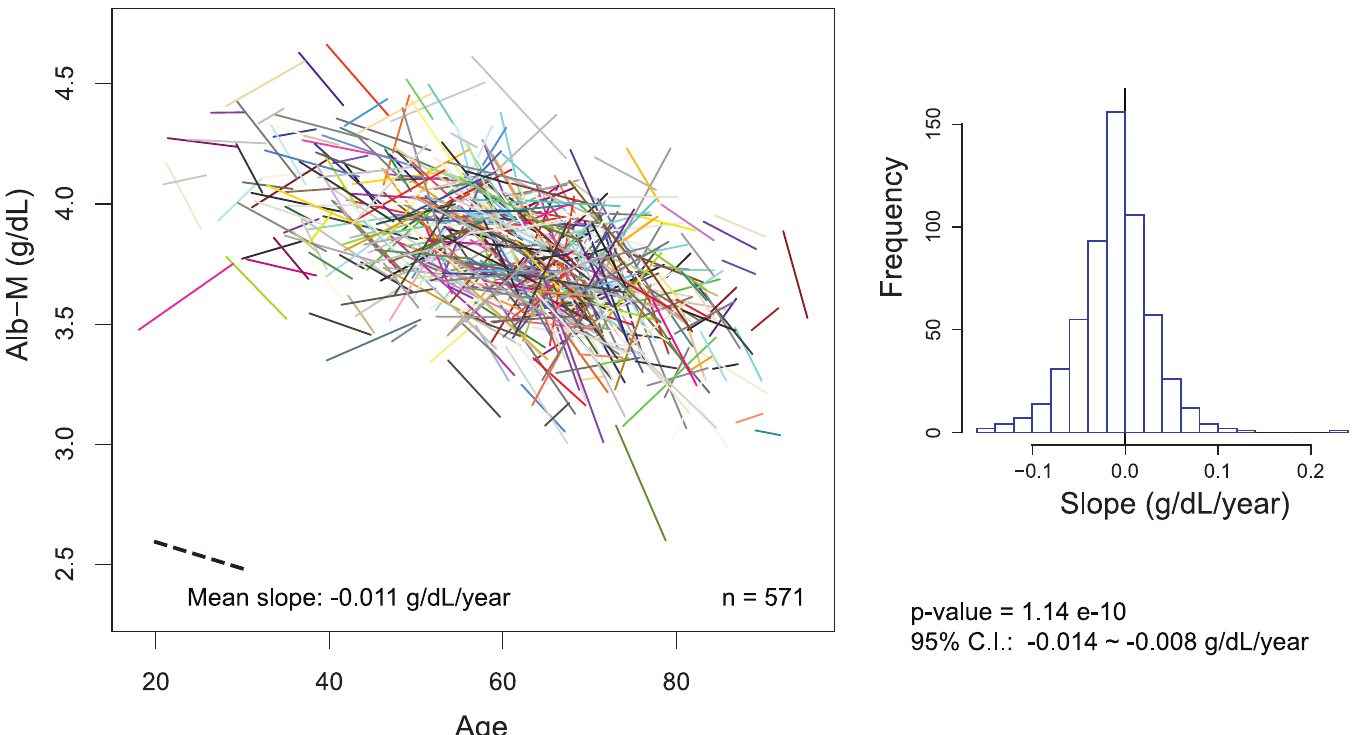
Fig 10. Overall Alb-M movement during the maintenance period of HD treatment. For each subject, a regression line was calculatedfrom a set of yearly Alb-M values, and the line was then positionedaccordingto patient age (left). The distributionof the slopes is shown in the histogram(right).